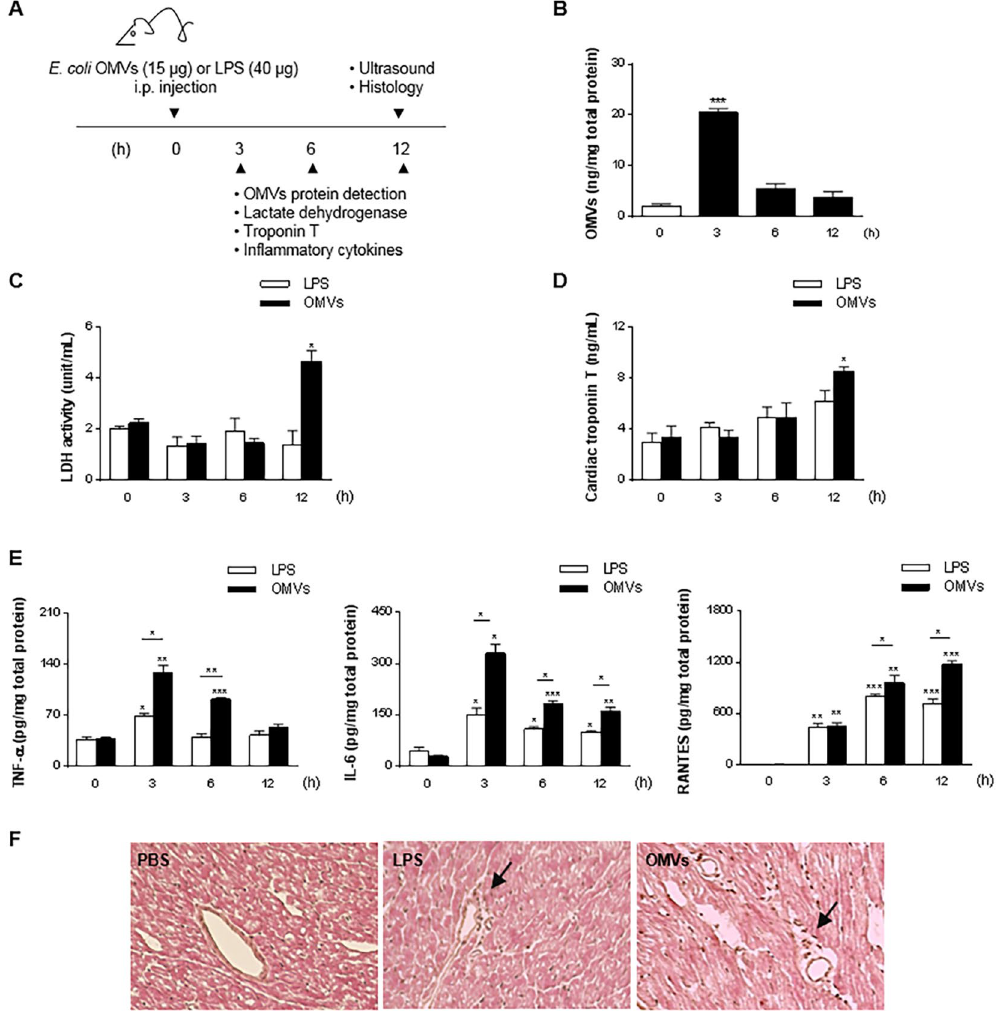
Figure 5. OMVs provoke cardiac injury and inflammation in vivo . ( A ) Study protocol for investigation of inflammation in heart. OMVs (15 µ g) or LPS (40 µ g) was injected i.p once, and then mice were sacrificed at 3, 6, and 12 h. ( B ) OMVs proteins were quantified in heart lysates using anti-OMVs antibody. ( C and D ) Lactate dehydrogenase ( LDH) ( C ) activity and Troponin T ( D ) levels were quantified in serum. ( E ) Inflammatory cytokines (TNF- α , IL-6, and RANTES) in heart lysates ( F ) Representative hematoxylin and eosin stained section of hearts at 12 h following administration of OMVs or LPS. Original magnification: 200x. * P < 0.05; ** P < 0.01; ** * P < 0.001; versus 0 h group. Error bars indicate SEM. n =